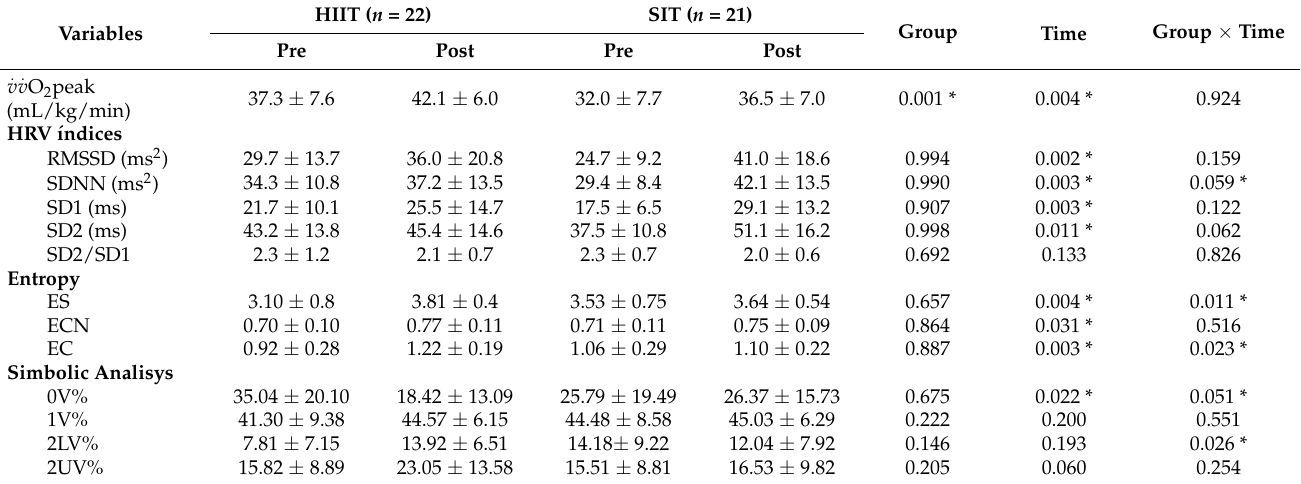
Table 2. Cardiorespiratory fitness, HRV indices and HR kinetics parameters at baseline and after the intervention